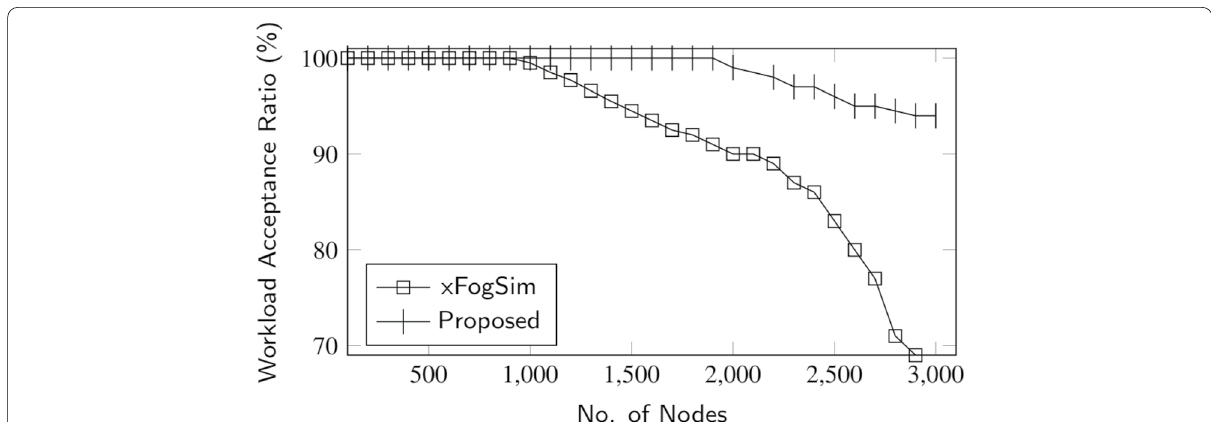
[17] when FognetSim starts dropping the incoming workloads when the ++ ++